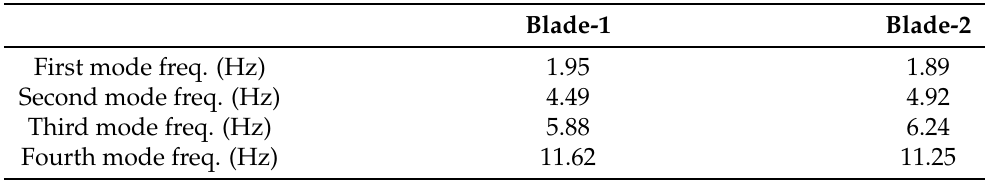
Table 6. First four natural frequencies of both blade models without damping. The frequencies are computed for the clamped blade root configuration.